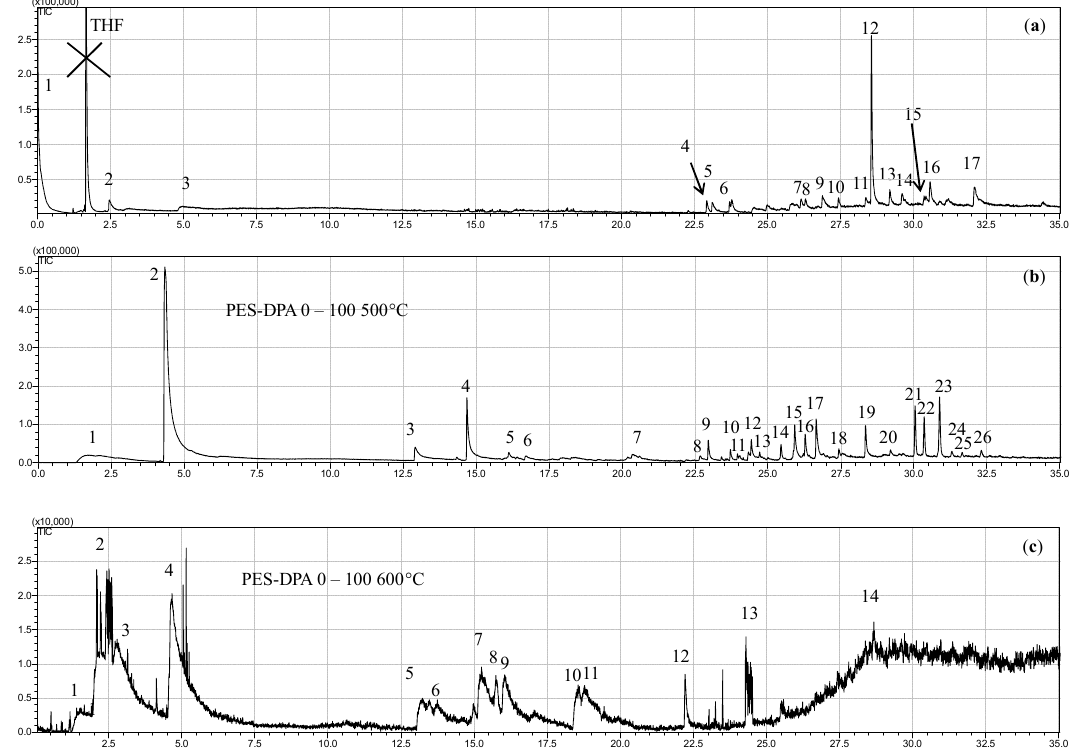
/ MS pyrograms P(ESDPA) taken at ( a ) 400, ( b ) 500 and ( c ) 600 ◦ Figure 11. Py-GC/MS pyrograms P(ESDPA) taken at ( a ) 400, ( b ) 500 and ( c ) 600 °C. Figure 11. Py-GC